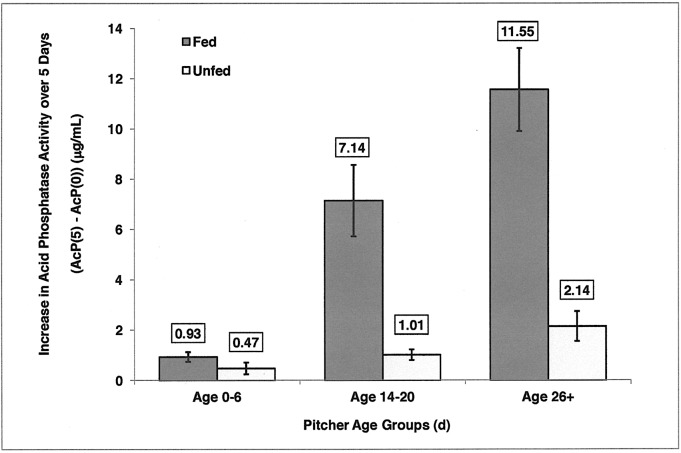
Initial acid phosphatase activity (AcP(0)) (μg/mL) subtracted from final acid phosphatase activity (AcP(5)) μg/mL) in fed (dark gray bars) and unfed (light gray bars) pitchers for three age groups of pitchers.Differences (mean ± 1 SE) increased with pitcher age, to a greater degree in fed pitchers than in unfed pitchers. (Samples sizes are: Age 0–6, Unfed, n = 14, Fed, n = 13; Age 14–20, Unfed, n = 14, Fed, n = 21; Age 26+, Unfed, n = 18, Fed, n = 22).